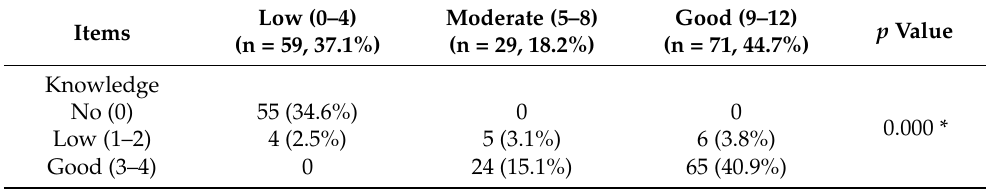
Table 3. Relation between physicians’ knowledge of RFS and their ability to manage RFS.